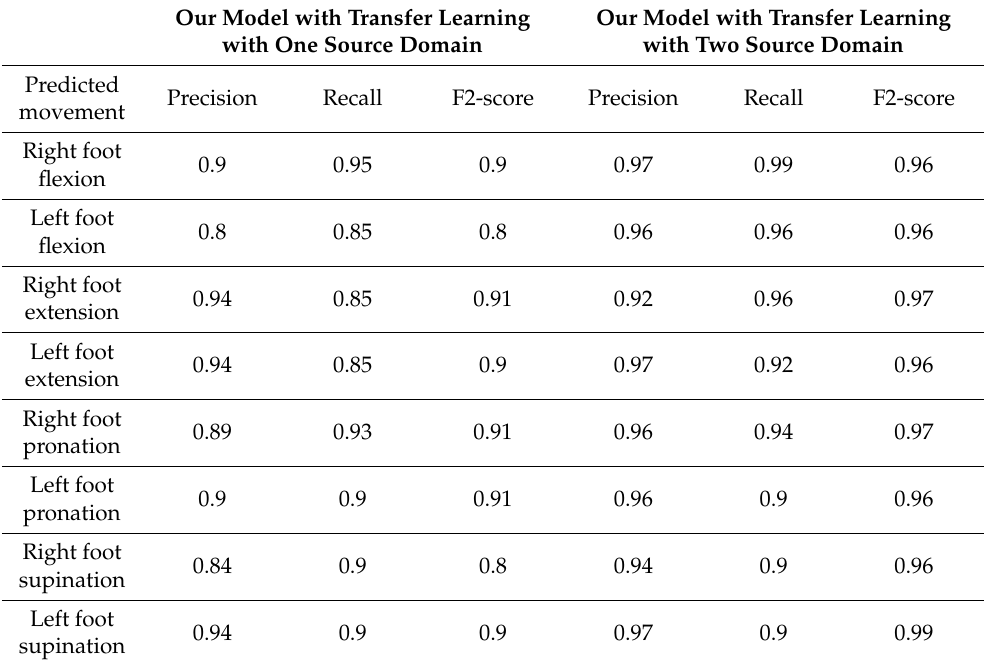
Table 7. Classification report of our model with transfer learning with one and two source domain model.